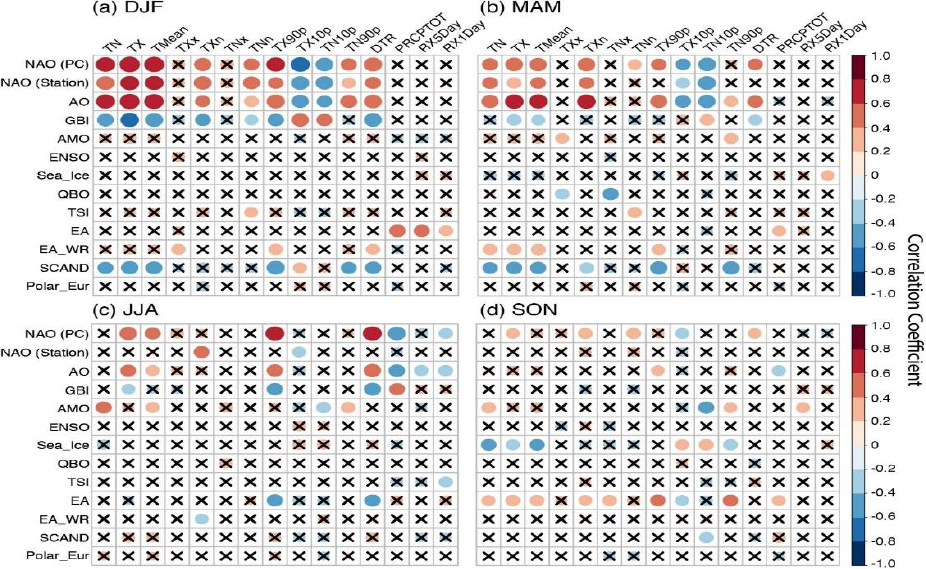
Figure 8. Seasonal correlation coefficients (1979–2015) between WP climate indices (mean temperature, TX/TN and ETCCDI indices from Table 1) and selected climate indices. Insignificant correlations ( p > 0.05) are marked with a black cross. ( a ) DJF. ( b ) MAM. ( c ) JJA. ( d ) SON. NAO, North Atlantic Oscillation (principal component and station-based); AO, Arctic Oscillation; GBI, Greenland Blocking Index; AMO, Atlantic Multidecadal Oscillation; ENSO, Multivariate El Niño Southern Oscillation Index; Sea_Ice, Arctic Sea Ice extent; QBO, Quasi-biennial Oscillation at 30 hPa; TSI, Total Solar Irradiance; EA, East Atlantic pattern; EA-WR, East Atlantic–Western Russian pattern; SCAND, Scandinavian pattern; Polar_Eur, Polar-Eurasian pattern. Data sources are listed in Supplementary